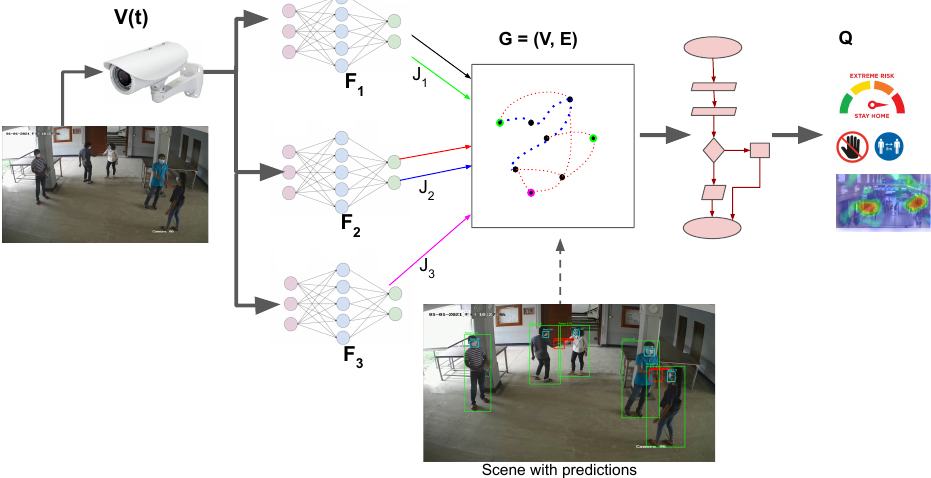
Scene with predictions